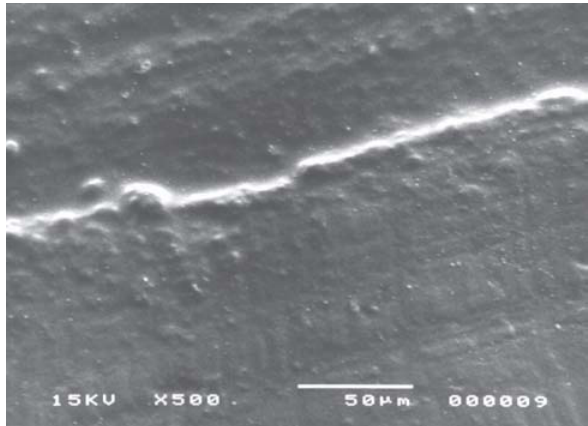
FIGURE 2- Soft start-polymerization technique/hybrid resin composite. Absence of gaps at the axial wall, showing perfect